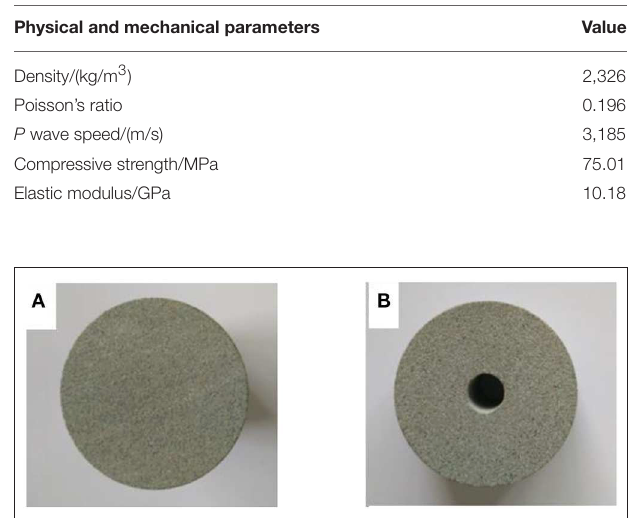
TABLE 1 | Physical and mechanical parameters of sandstone under static loading.